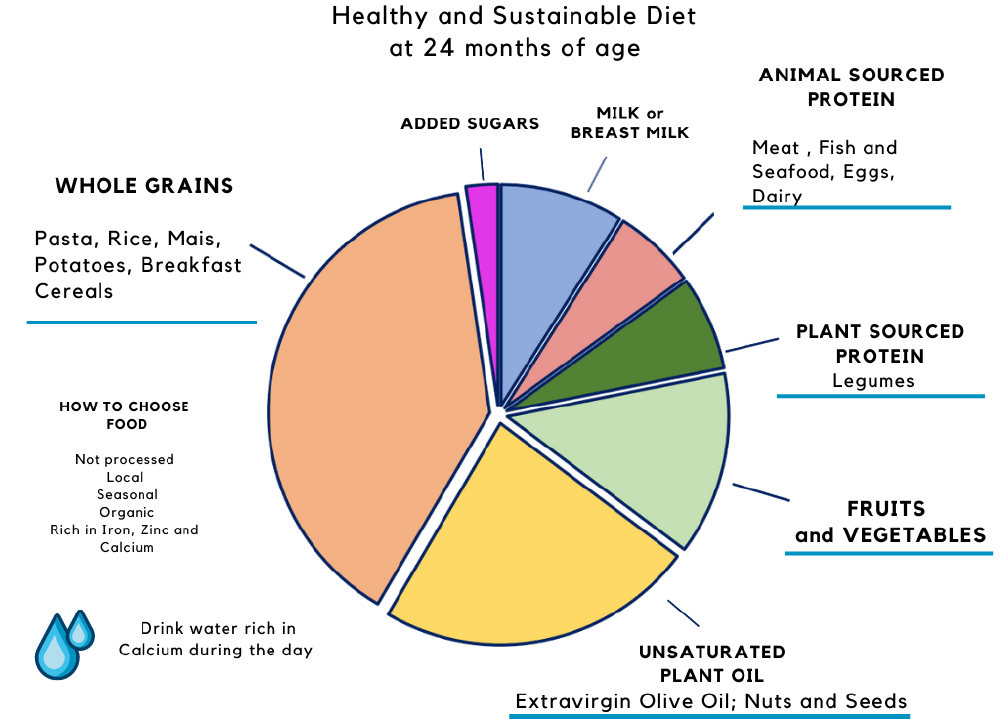
Figure 3. Proposal of a sustainable diet that respects EFSA nutritional recommendations for an infant at 24 months of age fed breast milk on demand and 2 complementary feeding meals. At this age, breast milk or substitutes supply should preferably provide an energy intake of between 10 and 20% of total energy.